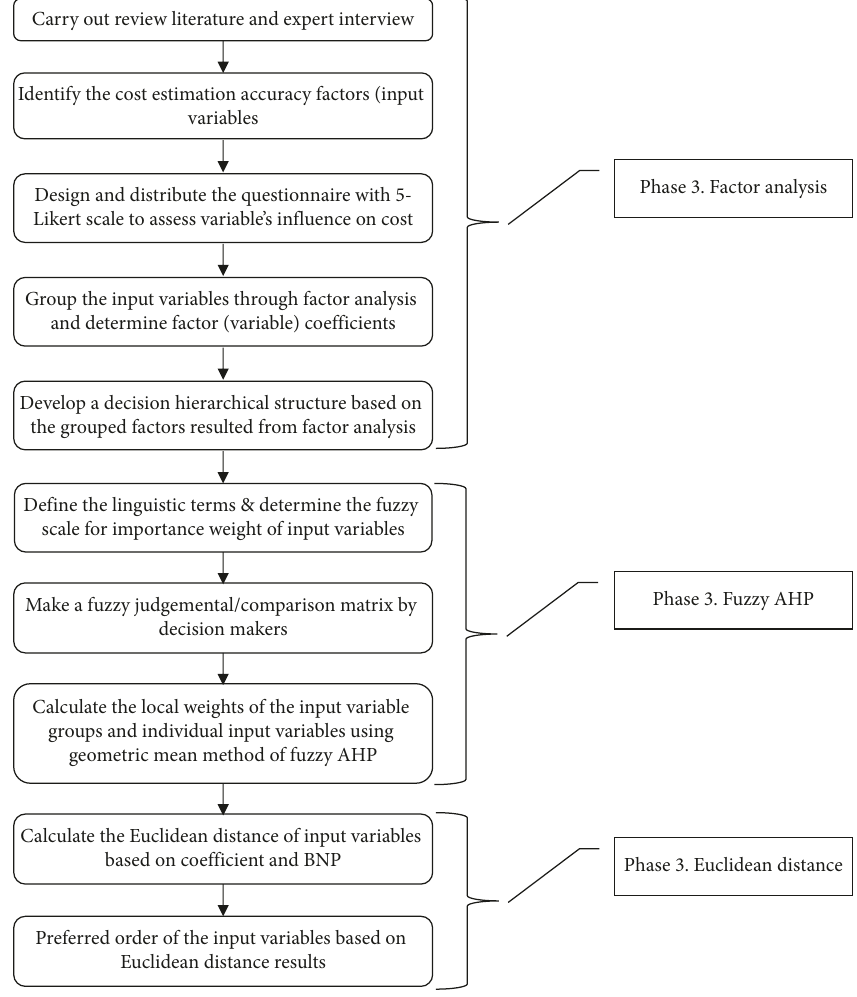
Figure 1: The steps for the proposed input variable selection approach.